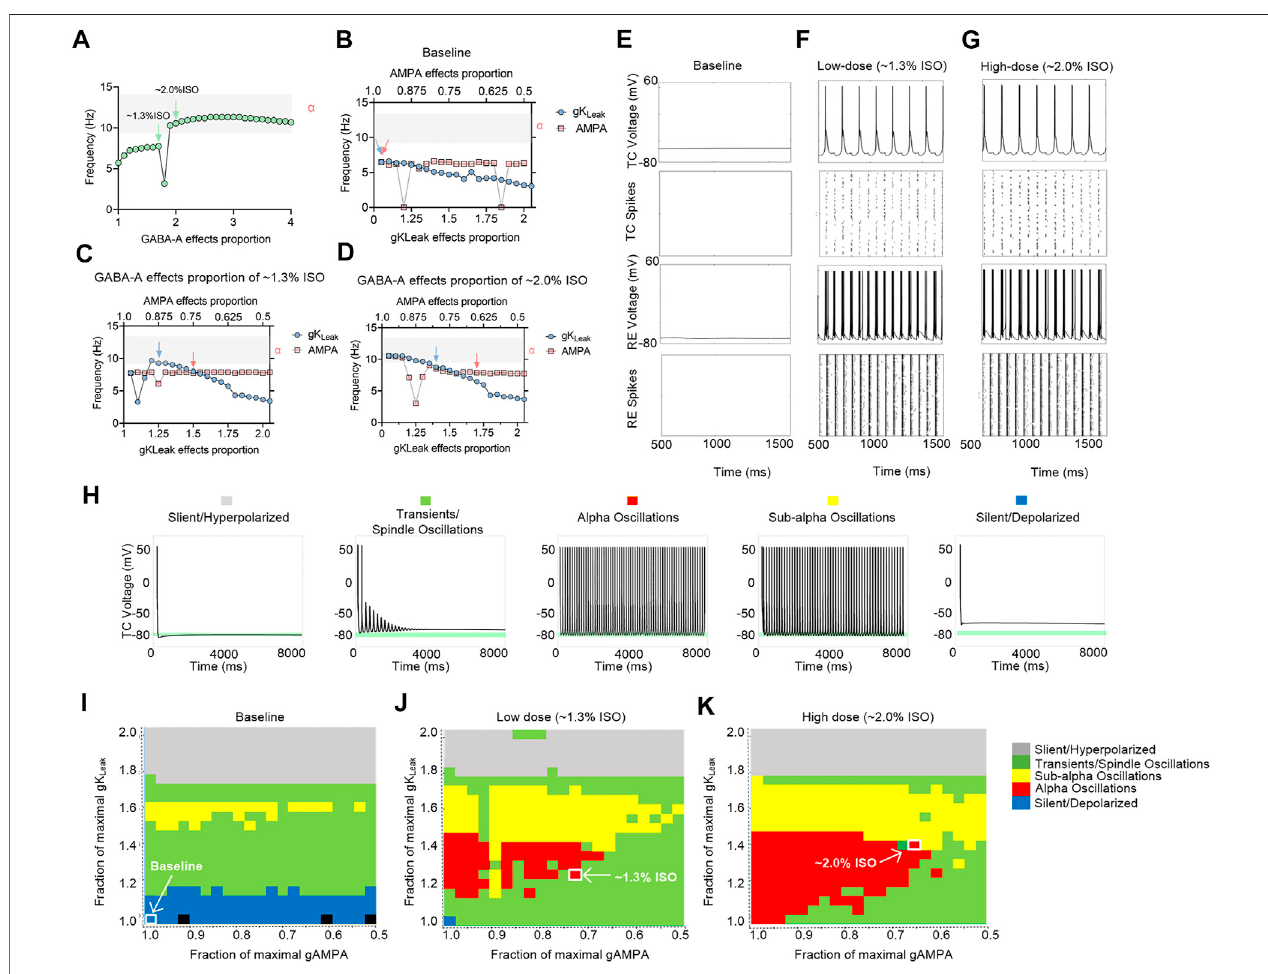
FIGURE 6 | Computational simulation of thalamic networks indicates that the overall effects of iso fl urane on AMPA, GABA A , and K Leak may lead to thalamic alpha oscillations. (A) FrequencyoftheTCspikeincreasestoalphaoscillations(grayshadow)alongwiththepotentiationofGABA A .ThemaximalAMPAcurrentdecreases(red dotted trace) and gK Leak increases (blue dotted trace): (B) no GABA A current potentiation; (C) GABA A current potentiation of ~1.3% iso fl urane; (D) GABA A current potentiation of ~2.0% iso fl urane; (E) under baseline (no iso fl urane potentiation of any molecular targets) conditions; (F) ~1.3% iso fl urane potentiation of GABA A current, AMPA current, and gK Leak ; and (G) ~2.0% iso fl urane potentiation of those; representative voltage traces and spike rastergrams of TC and RE neurons; (H) representative TC cell voltage trace during silent, hyperpolarized stimulation, transients, spindling oscillation simulation, subalpha oscillation simulation, and silent, depolarized simulation. Behavioral regimes of thalamic simulations across different GABA A potentiation levels of the gK Leak — AMPA current plane: (I) baseline; (J) 1.3% iso fl urane;and (K) 2.0%iso fl urane.Eachsimulationisrepresentedbyapixelandcoloredaccordingtoitsmanuallyclassi fi edbehavioralregime.Arrowsindicatethealpha oscillations corresponding to the parameters in Supplementary Table S1 . ISO, iso fl